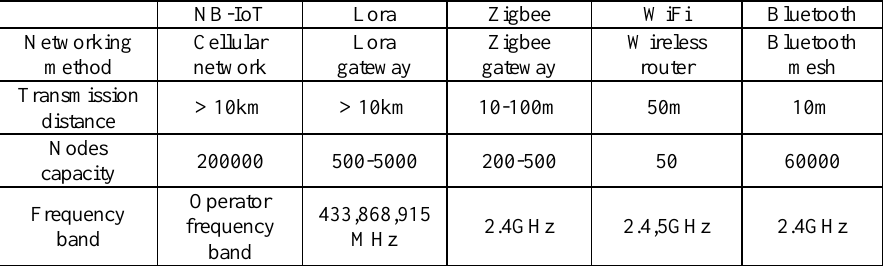
Table. 1. Comparison of different communication